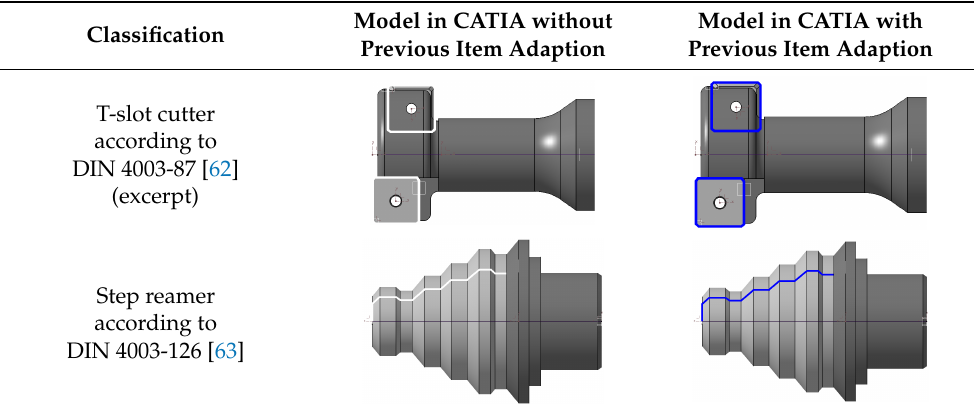
Table 3. Demonstration of the item adaptation using the example of sketch coloring (for clarity, the sketches have been highlighted). Classification